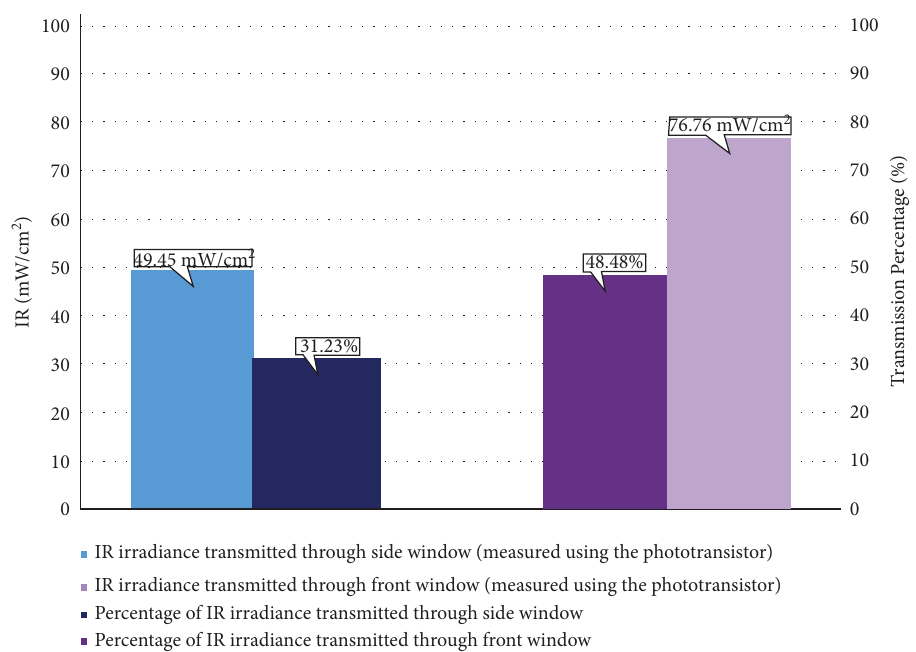
Figure 6: Transmitted IR irradiance through the side (represented in orange color) and front (represented in yellow color) windows in a Toyota Camry model 2001 vehicle.